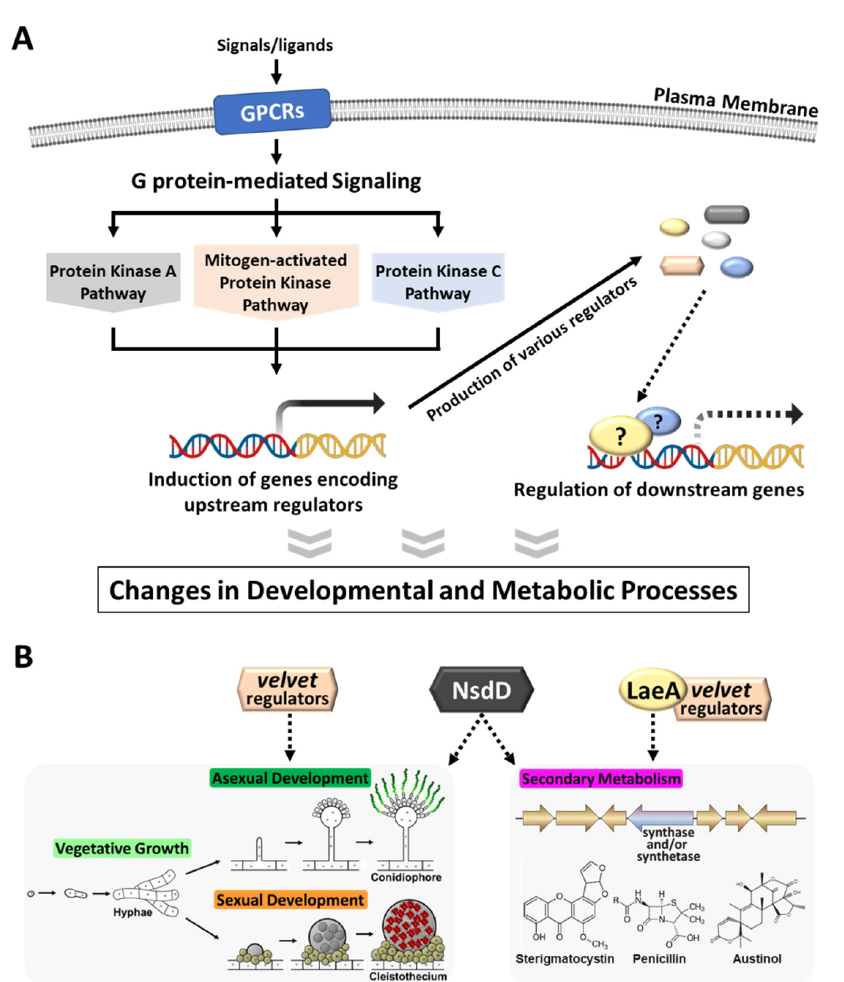
Figure 1. A schematic overview of upstream regulation in Aspergillus species. ( A ) The heterotrimeric G protein-mediated signaling pathway, initiated by binding of ligands or signals to the corresponding G-protein coupled receptors (GPCRs), relays external environmental signals inside the cell and initiates downstream signaling pathway(s): protein kinase A (PKA), mitogen-activated